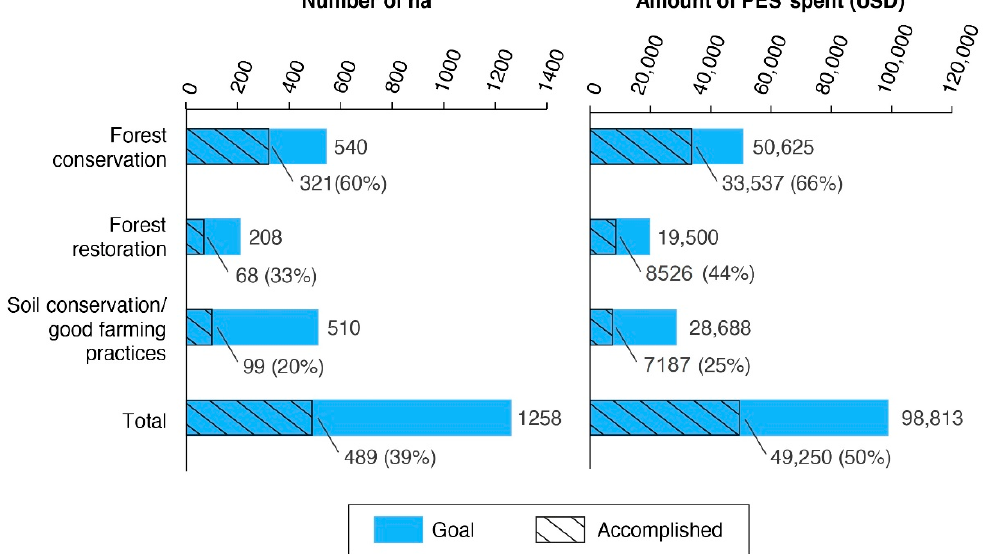
Figure 5. Achievements compared to the goals of the Water Producer Project, Piracicaba, Capivari, and Jundiai Watershed, Atlantic Forest, Brazil, in terms of implementation area (number of hectares) and PES funds spent. Percentages are achievements in relation to the original goal.